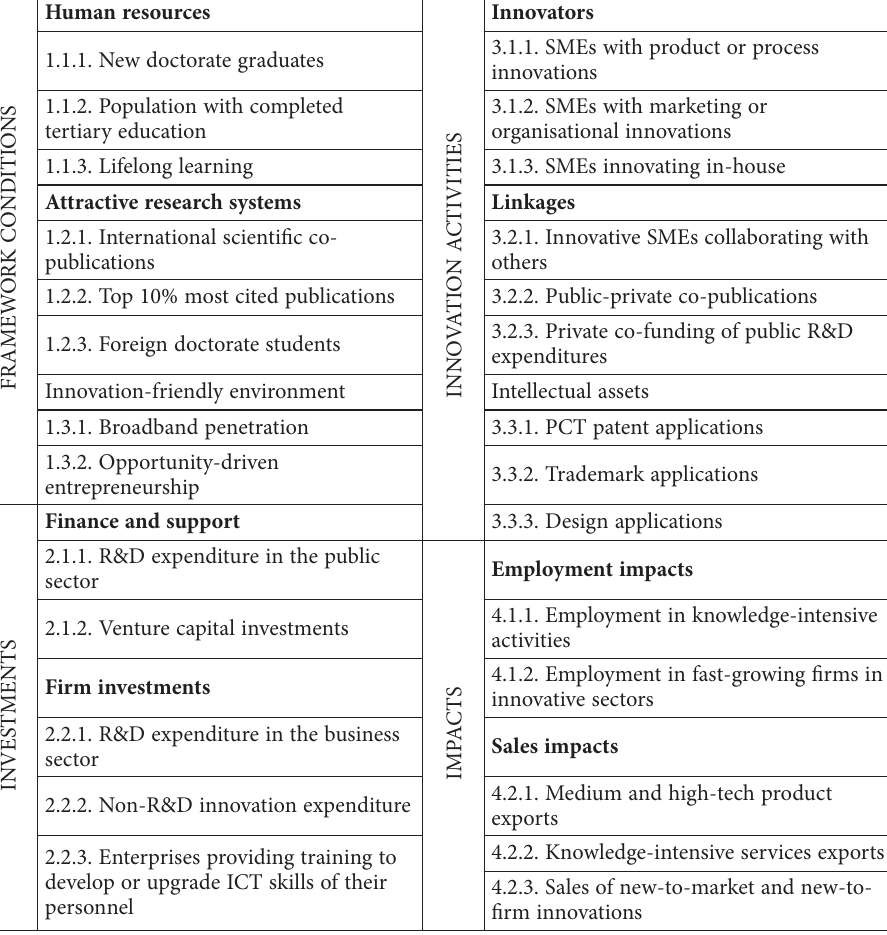
N O T I D I N O C K R O W E M A R F